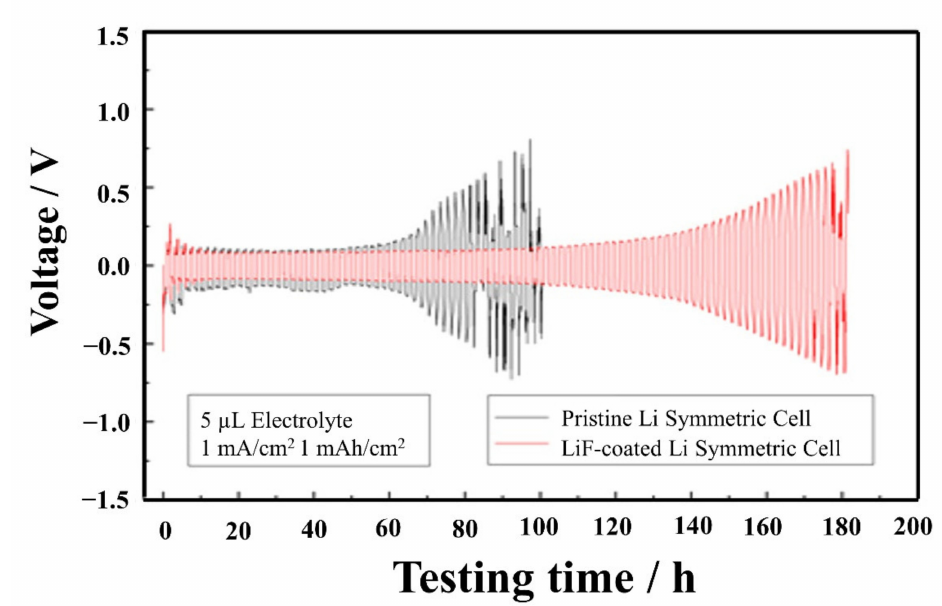
Figure 3. Li-Li Symmetric Cell performance for Bare (black) and LiF-coated (red) Li metal at 1 mA cm − 2 with 5 µ L of carbonate electrolyte [89]. Reproduced with permission [89]. Copyright 2018, American Chemical